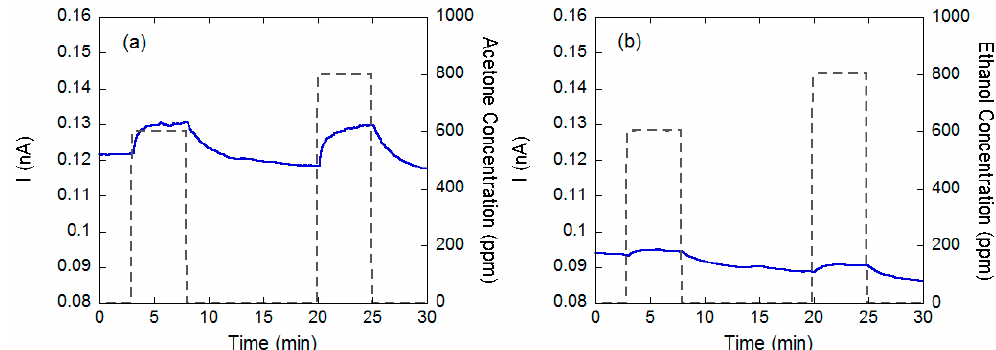
Figure 8. Dynamic response of a surface ionization device with planar layout, based on CuO nanowires to acetone ( a ) and ethanol ( b ).